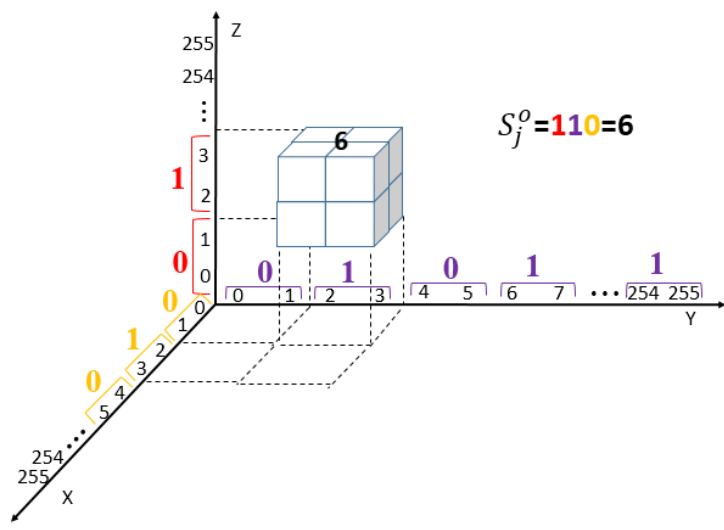
Figure 8. Locating the basic structure for embedding by combining ranges of three axes.